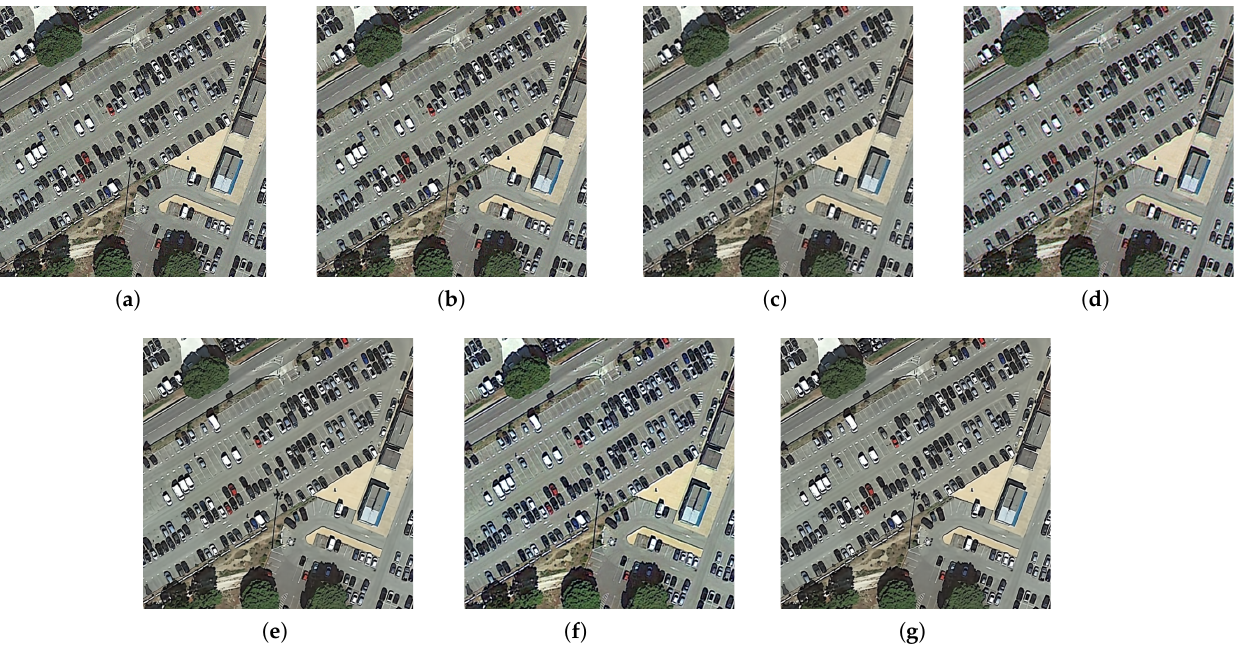
Figure 10. Comparison of visual results of different SR methods with × 2 super-resolution on the WHU-RS19 [40] dataset (parking lot scene). ( a ) HR. ( b ) Bicubic.( c ) EDSR [68]. ( d ) RCAN [81]. ( e ) RDN [64]. ( f ) SAN [83]. ( g ) NLSN